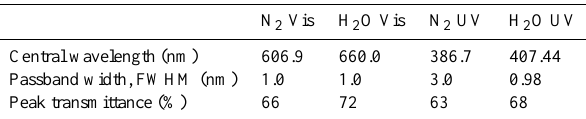
Table 1. Pass band interference filter characteristics of the Raman channels. N 2 Vis H 2 O Vis N 2